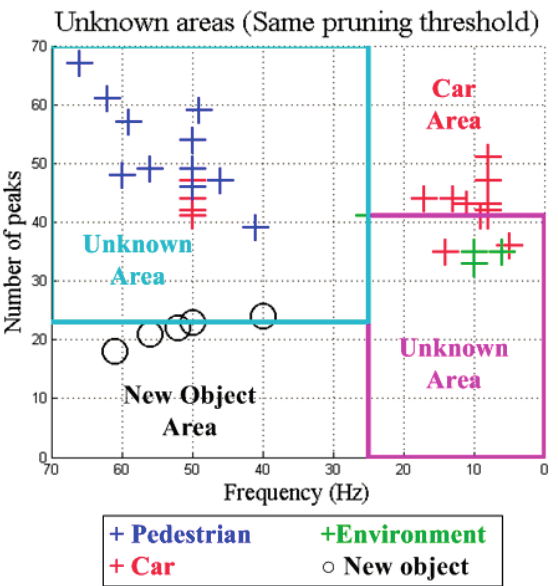
Figure 17. Decision tree with the same pruning threshold (0.1).